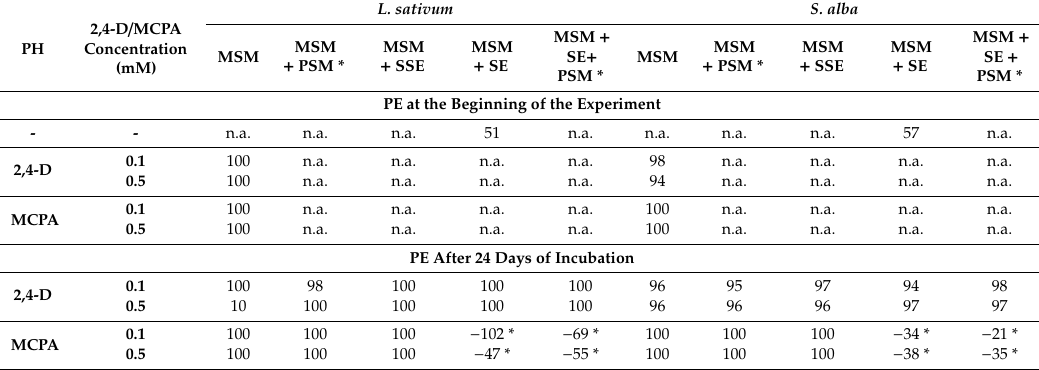
Table 6. Root Growth Inhibition (PE) in Samples Before and After 24 Days of